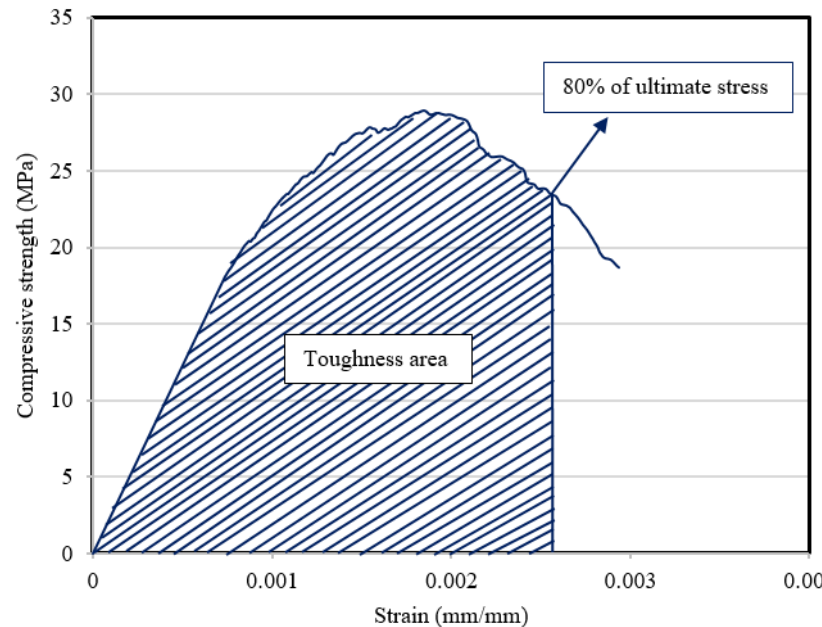
Figure 18. The calculated toughness area under stress-strain curve.